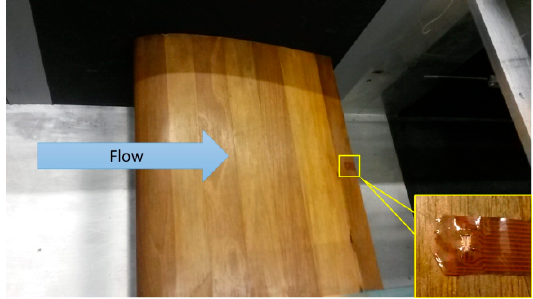
Figure 3. Picture of the experimental setup with the sensor placed at the trailing edge of the NACA0020 airfoil model—view inside the wind tunnel .